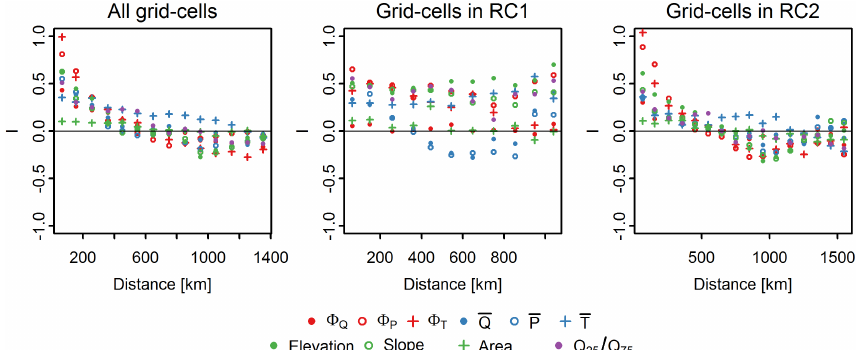
Fig. B1. Spatial correlation functions for all variables of the correlation analysis, estimated using Moran’s I